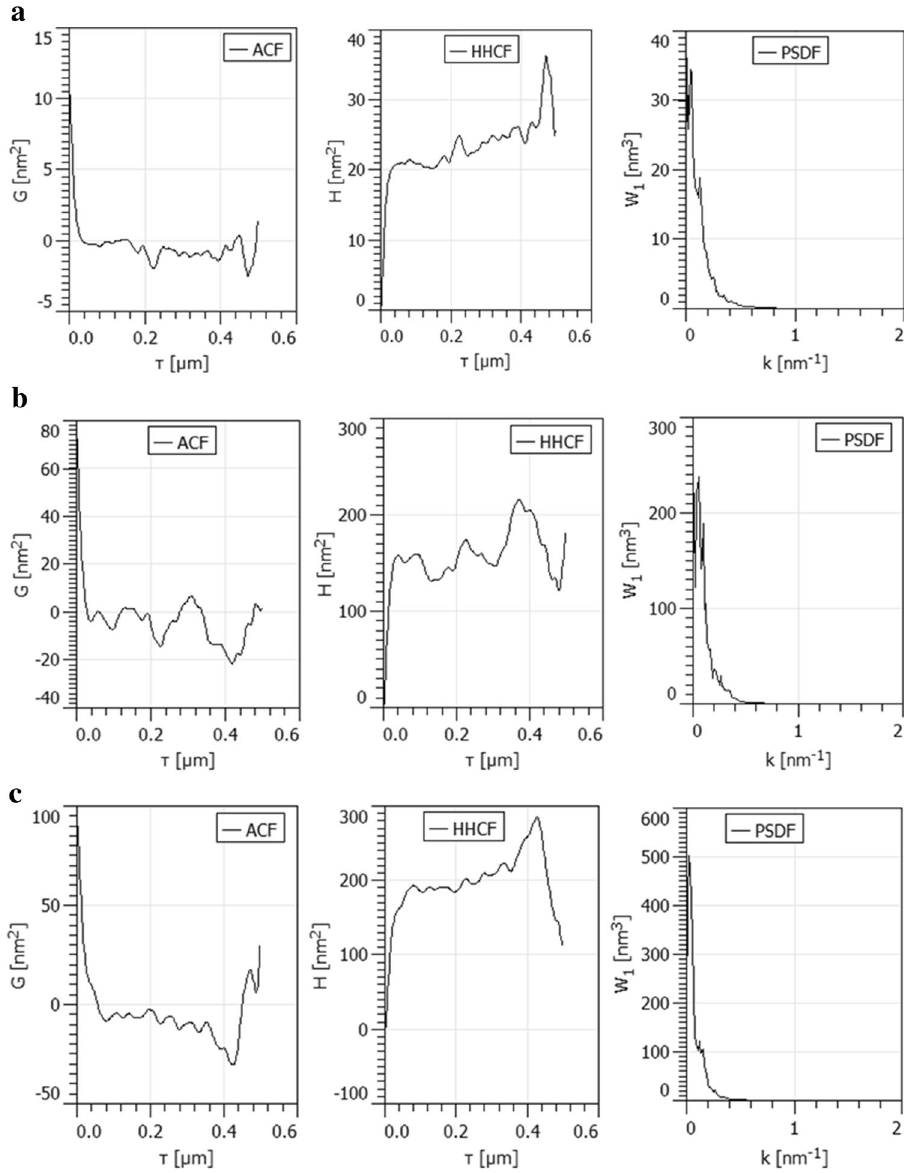
Figure 8. The ACF, HHCF and PSDF functions computed for samples ( a ) #1, ( b ) #2 and ( c ) #3 deposited at various times 10, 25 and 40 min (Gwyddion software, ver. 2.53,